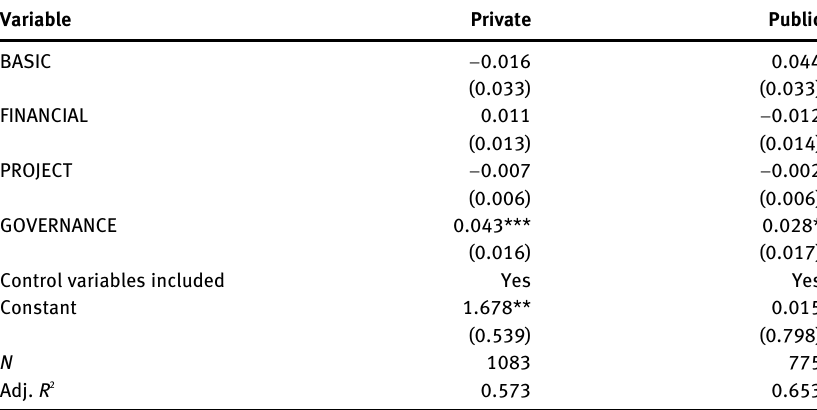
Table  : Robustness check: fundtype. Variable Private